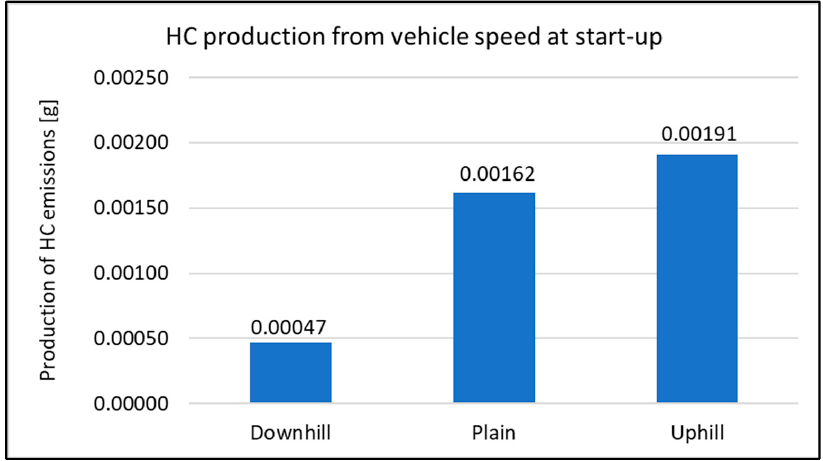
Figure 8. HC production at start-up.